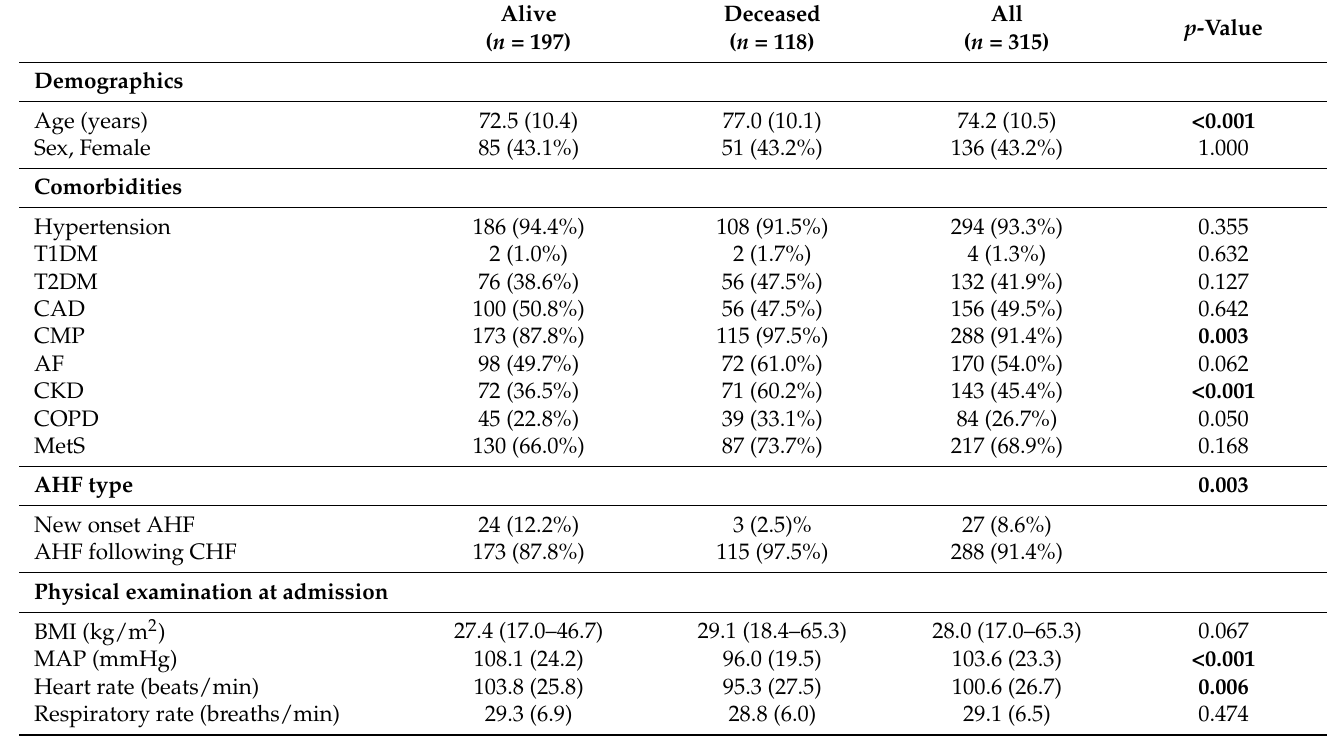
Table 1. Baseline characteristics of AHF